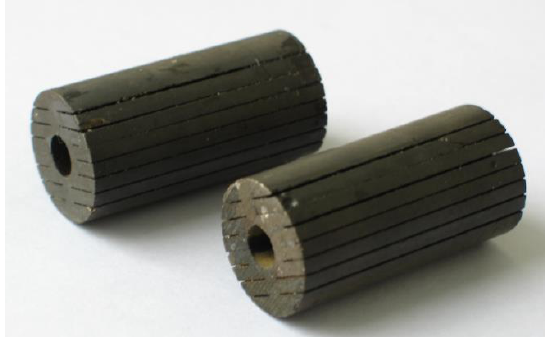
Figure 8. The Terfenol-D rod with digital slots.